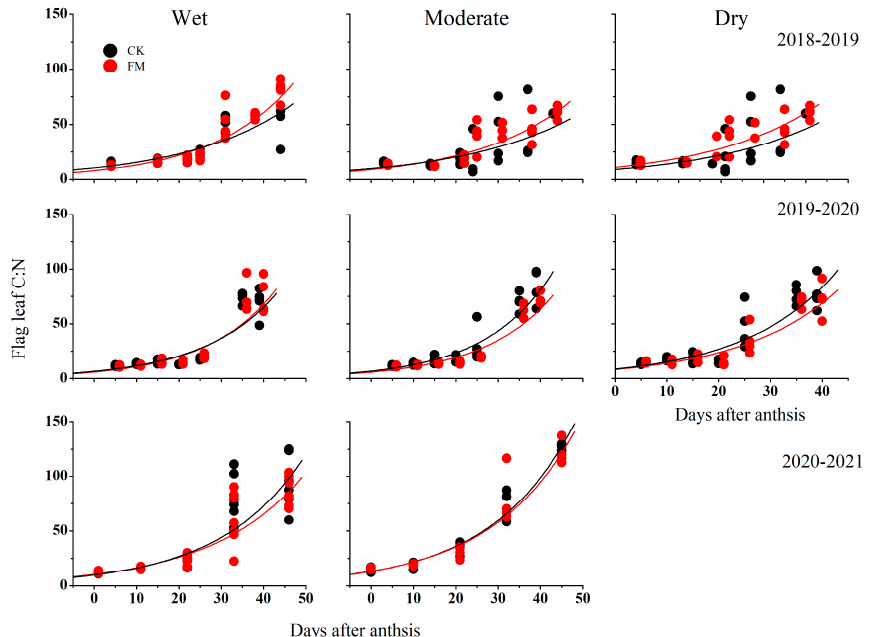
Figure 4. Change in C:N of flag leaf after anthesis of wheat grown under two in a factorial with two soil covers (plastic film mulching, FM, bare ground control, CK) and three levels of initial soil water (wet, moderate, dry) in three seasons. Table 3. Coefficients of exponential equation (y = a e ( b x) ) that described the change in flag leaf C:N ratio after anthesis under plastic film mulching (FM) and bare ground control (CK) at different initial soil water levels (wet, moderate, dry). In 2020–2021, high rainfall during fallow precluded the dry treatment, and results are for moderate ( n = 4) and wet ( n = 8) treatments